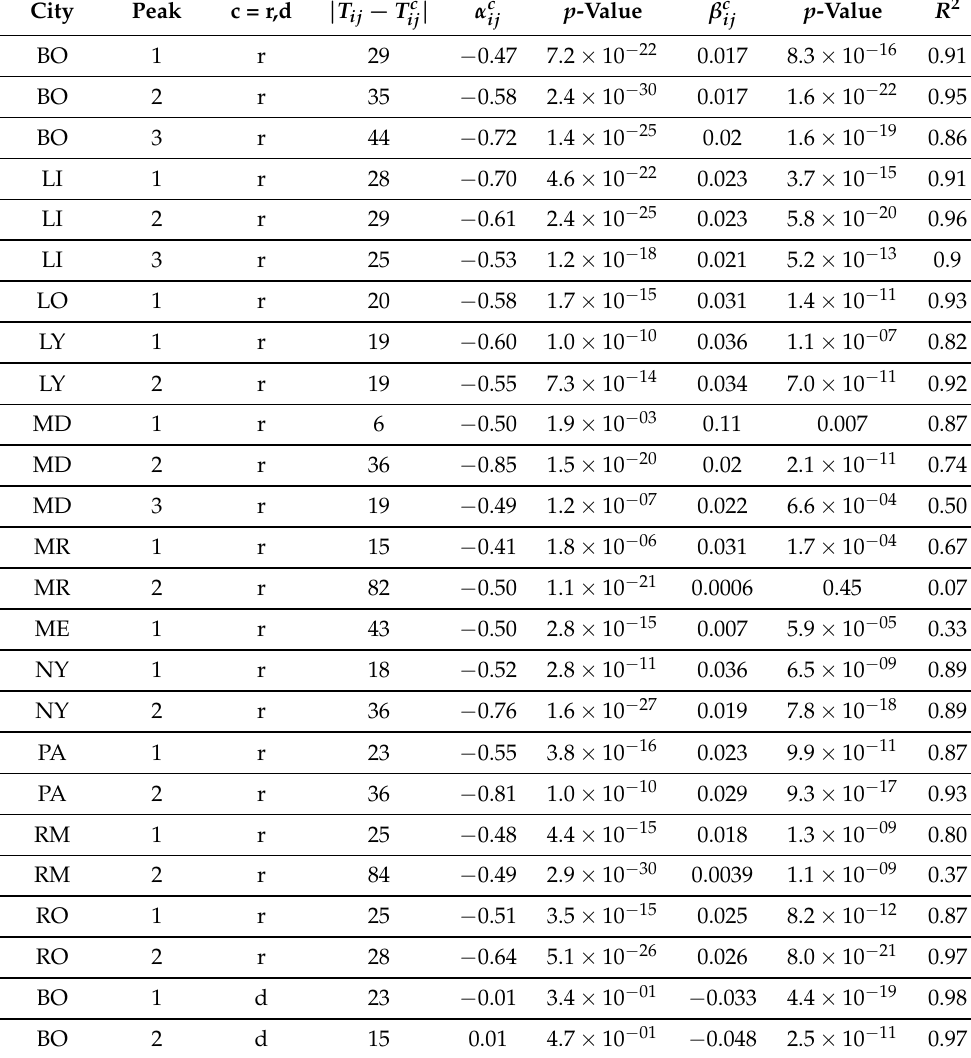
Table 4. Estimation in the 50 % regression